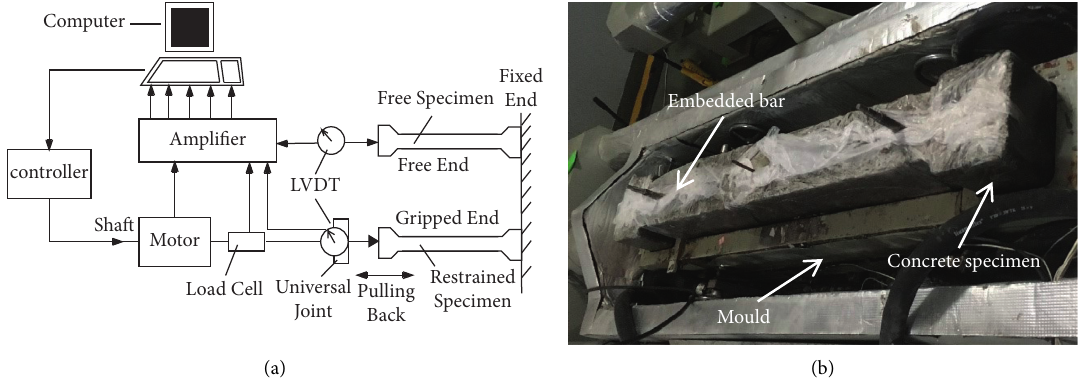
Figure 2: Sketch of a temperature stress test machine (TSTM) and removed concrete specimen. (a) Sketch of TSTM; (b) removed concrete